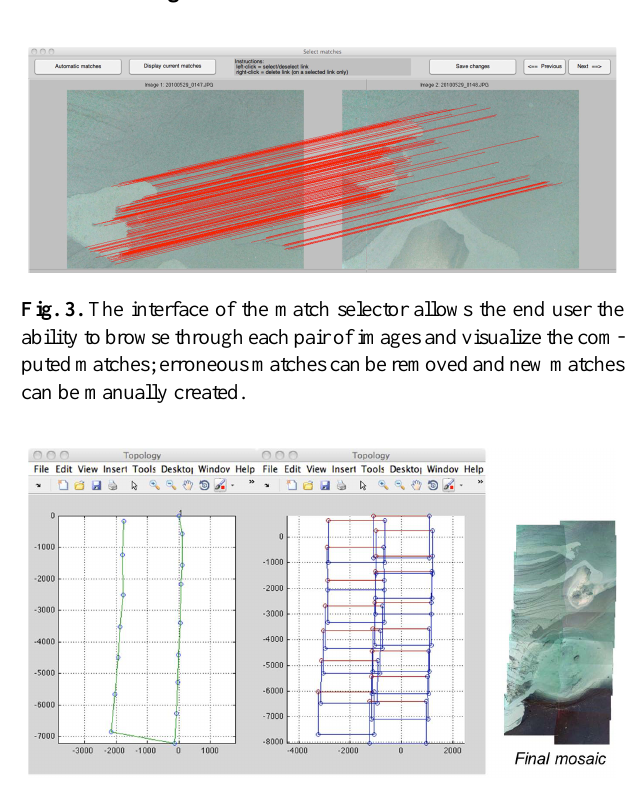
Fig. 4. Illustration of the initial topology. Left: estimation of the center position of each image. Middle: estimation of the projection of the image frames onto the 2-D plane of the mosaic. Right: corre- sponding